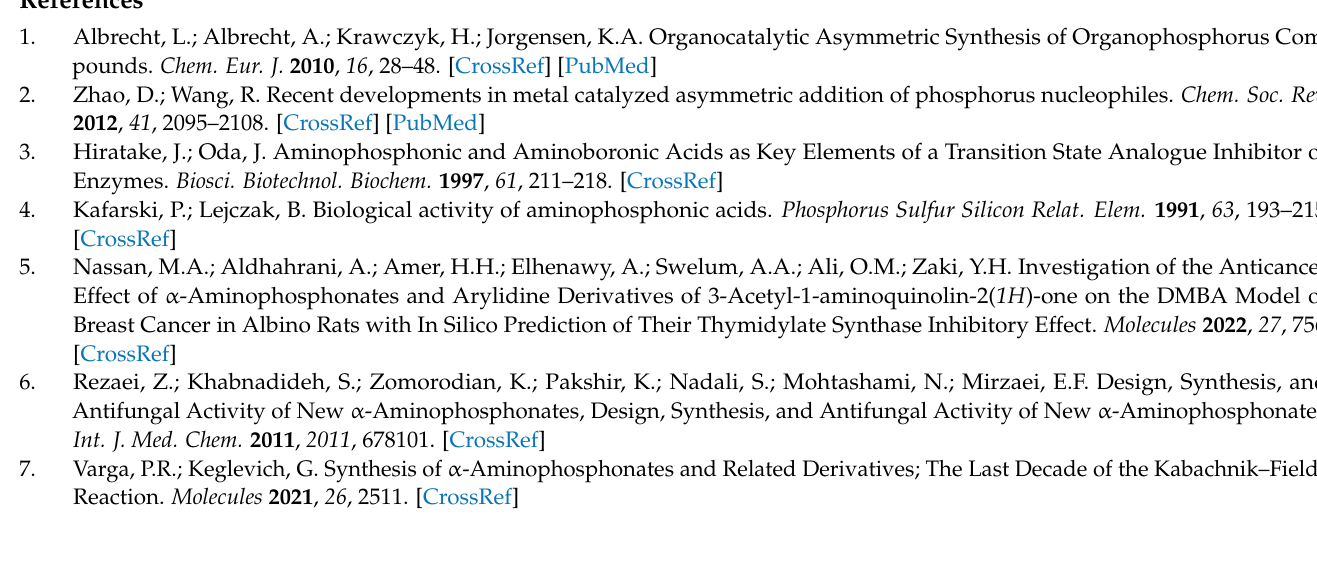
phosphite. Figure S58: 1 HNMR (400 MHz, CDCl 3 ) spectra of methyl (4-chlorophenylethyl) phos- phite. Figure S59: 13 CNMR (100 MHz, CDCl 3 ) spectra of methyl (4-chlorophenylethyl) phosphite. Figure S60: 31 PNMR (162 MHz, CDCl 3 ) spectra of methyl (4-chlorophenylethyl) phosphite. Figure S61: 1 HNMR (400 MHz, CDCl 3 ) spectra of methyl (4-nitrobenzyl) phosphite. Figure S62: 13 CNMR (100 MHz, CDCl 3 ) spectra of methyl (4-nitrobenzyl) phosphite. Figure S63: 31 PNMR (162